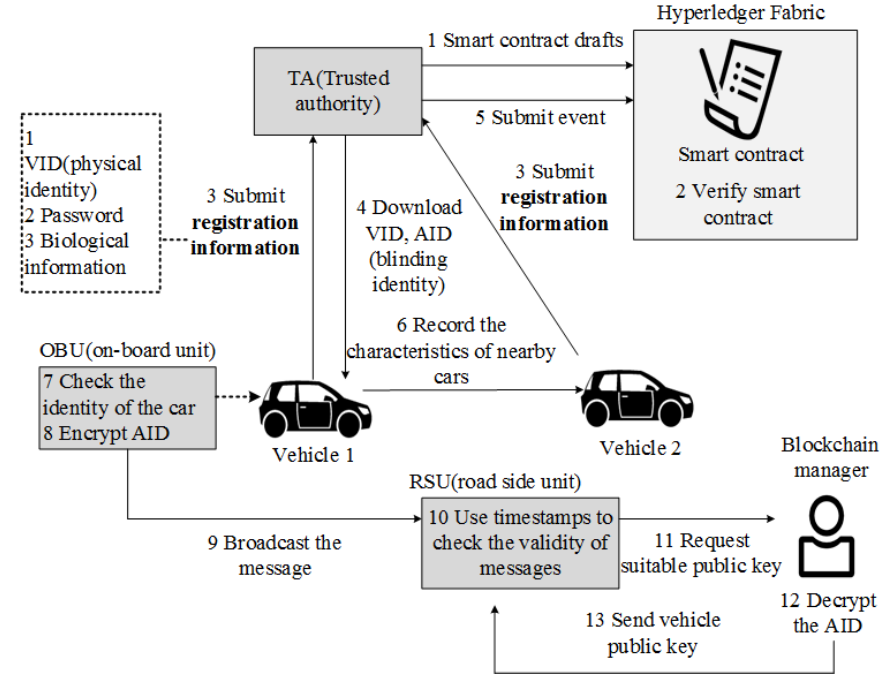
Figure 33. Reconstruction diagram of reference [65].